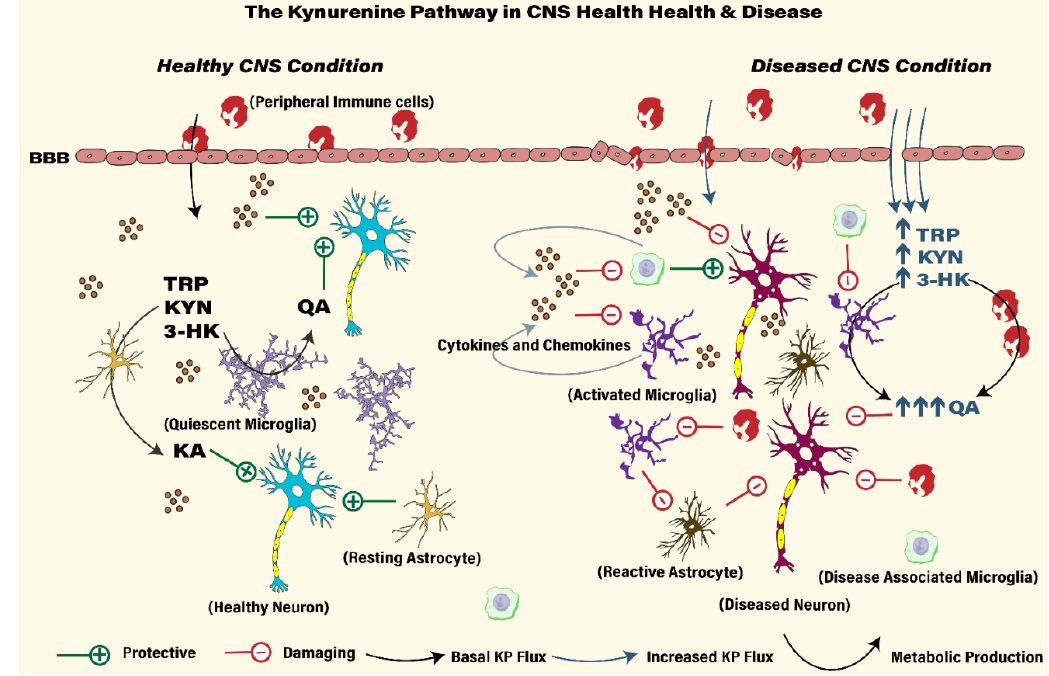
Figure 2. KP Metabolic Balance in CNS Health and Disease. Under healthy conditions, the intact BBB limits the entry of metabolites, xenotic material and non-CNS cells tightly regulating brain homeostasis where KP metabolites modulate oxidative stress, neuroinflammation and neurotransmission. Under CNS disease conditions, neuroinflammatory stimuli, including systemic and local insults, disrupt physical, genetic and metabolic checkpoints. The cascade of chronic inflammation ensues allowing an enhanced flux of toxic KP metabolites in the CNS system in addition to gliosis mediated release of cytokine, chemokines and KP metabolites that fuels the fire to this vicious loop [73,78,204–207].